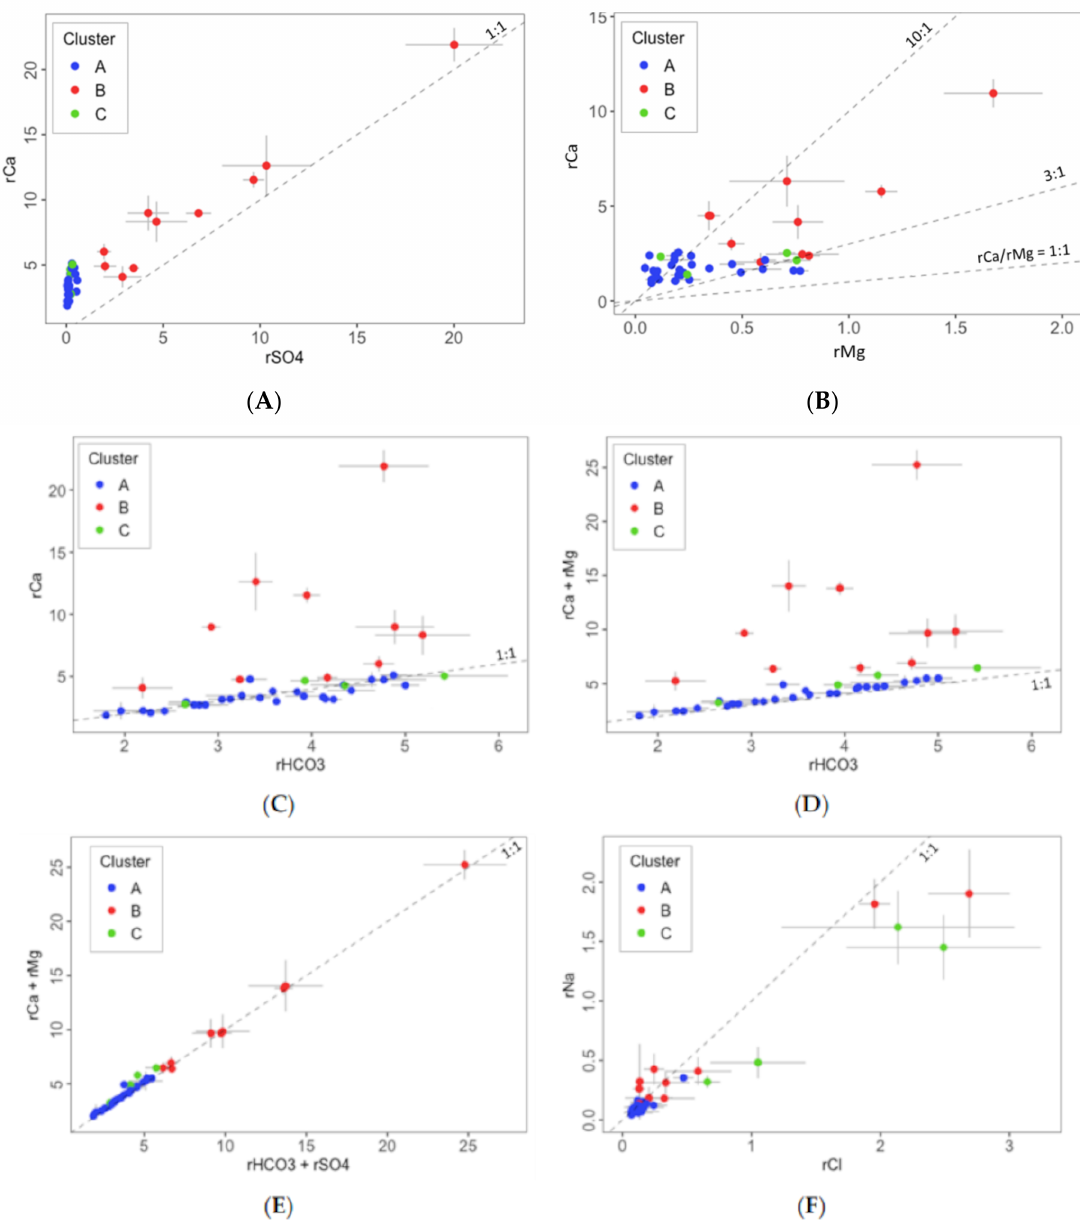
Figure 5. Bivariate relationship graphs of major ions in spring water samples ( A ) rCa/rSO 4 ; ( B ) rMg/rCa; ( C ) rHCO 3 /rCa; ( D ) (rMg + rCa)/rHCO 3 ; ( E ) (rCa + rMg) and (rHCO 3 + rSO 4 ); ( F ) rNa vs. rCl), where ‘r’ means that the concentration is given in